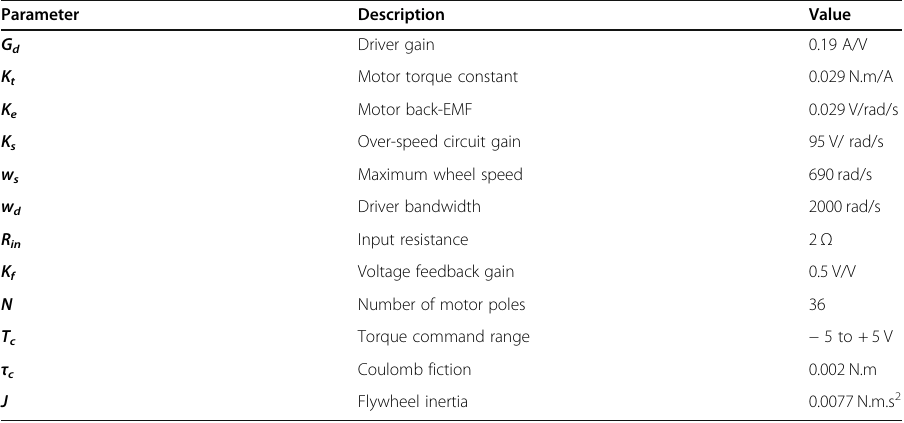
Table 1 ITHACO type-A RW main parameters Parameter